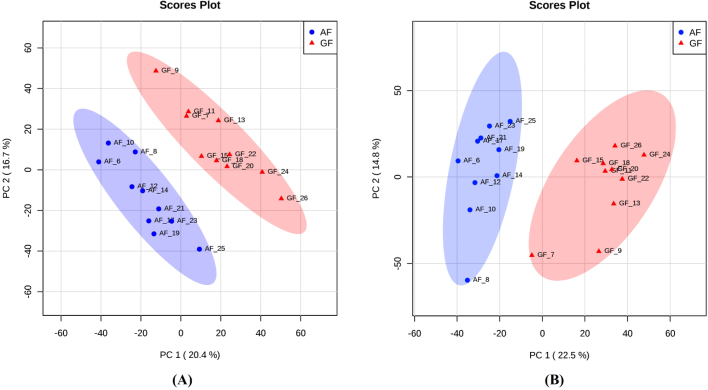
PCA score plots for the metabolomics profiles of C. idellus muscle samples (n = 10). PCA score plots for the metabolomics profiles of muscle samples from female (A) and male (B)C. idellus. AF group, blue points; GF group, red triangles.